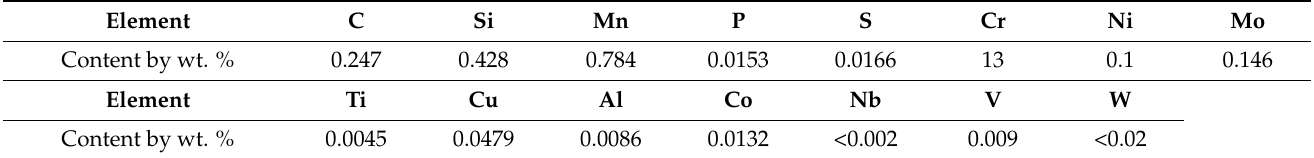
Table 4. Chemical composition of the samples made of X20Cr13 steel (according to [8]).